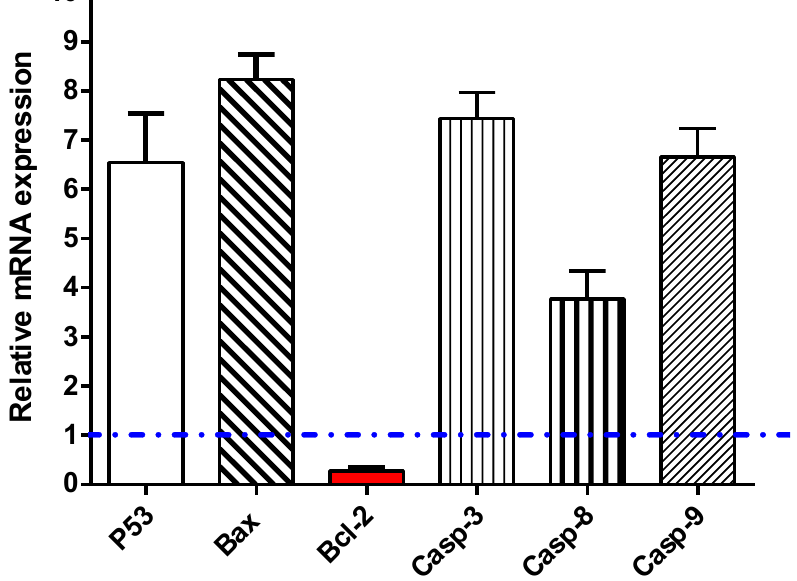
Figure 5. RT-PCR of apoptosis-related genes in MCF-7 untreated and treated with the phenolic extract at IC 50 of 16.67 µg/mL, 48 h.